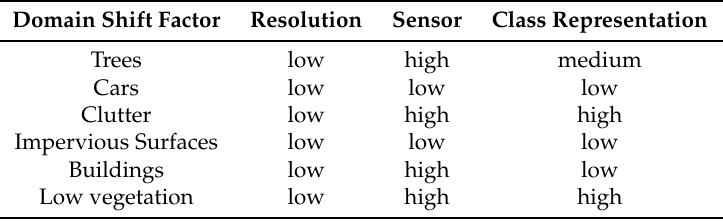
Table 2. Domain shift analysis when passing from Potsdam to